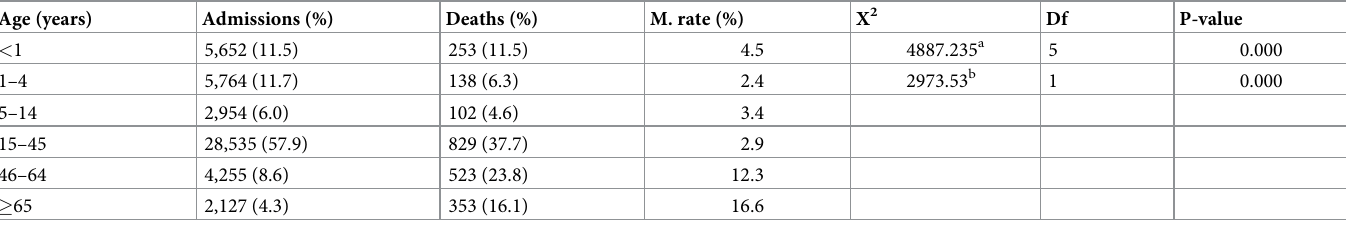
Table 2. Frequency of morbidity and mortality of the studied population based on age.